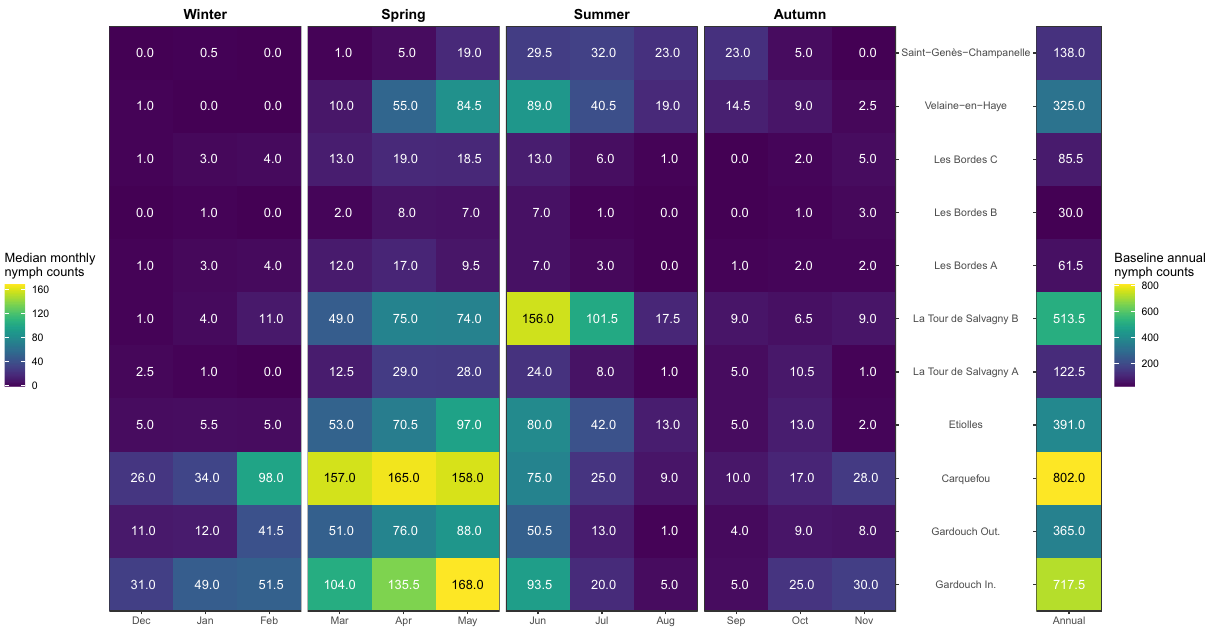
Figure 5. Monthly median nymph counts (left), and baseline annual nymph counts (right) obtained from 11 sampling sites. Meteorological seasons of temperate areas of the northern hemisphere: Spring, 1st March to